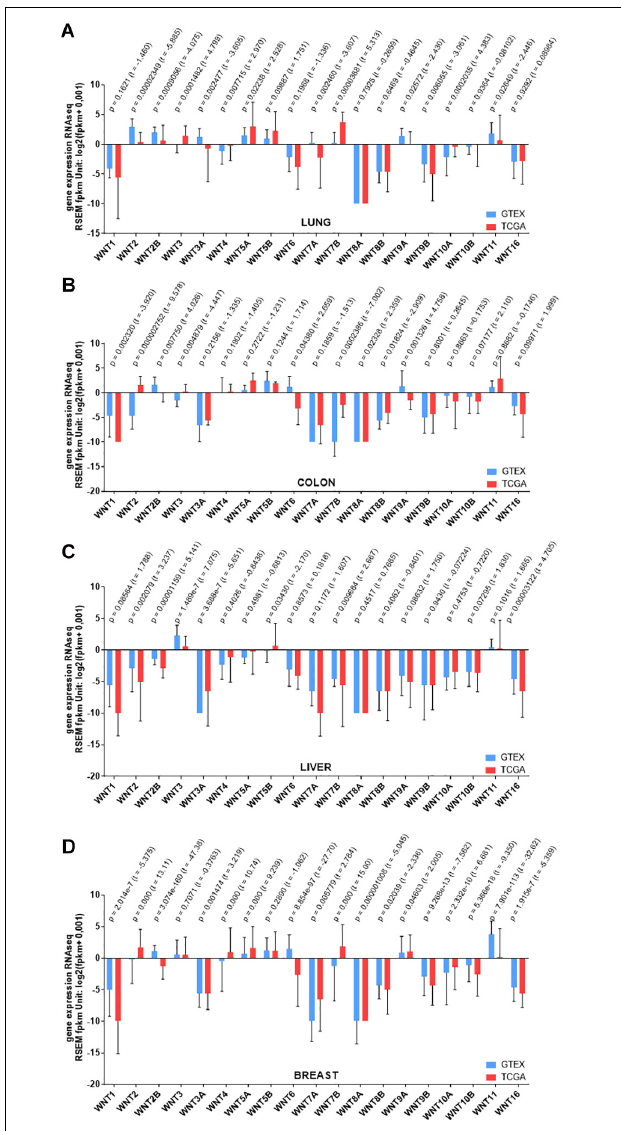
FIGURE 3 | RNAseq gene expression levels of Wnt ligands in different cancers. (A) Lung cancer (B) Colon cancer (C) Liver cancer (D) Breast cancer. The data were downloaded from https://xenabrowser.net/on August 10, 2020. For each cancer type, data were filtered from the browser extension data set on the TCGA TARGET GTEx dataset, which includes approximately 13 thousand genes. Studies were obtained from GTEx project and TCGA. Gene expressions were analyzed using RSEM fpkm method. Significance was calculated using Welch’s t -test and graphs were generated using GraphPad Prism